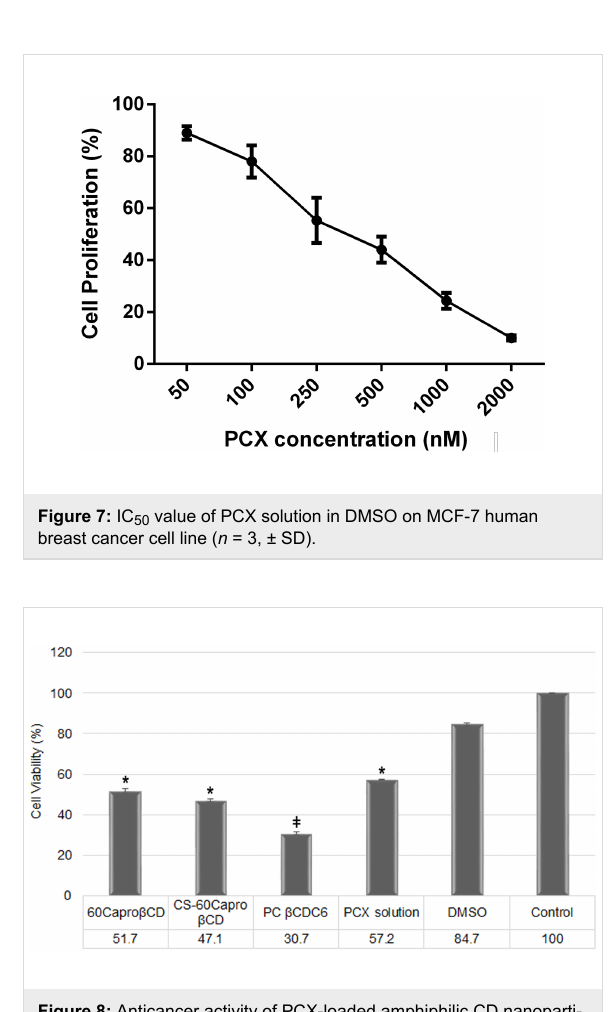
Figure 8: Anticancer activity of PCX-loaded amphiphilic CD nanoparti- cle formulations and PCX solution in DMSO on MCF-7 human breast cancer cell line after 48 h of incubation (All CD nanoparticle formula- tions and PCX solution contain 250 nM PCX) ( n = 3, ± SD). Note